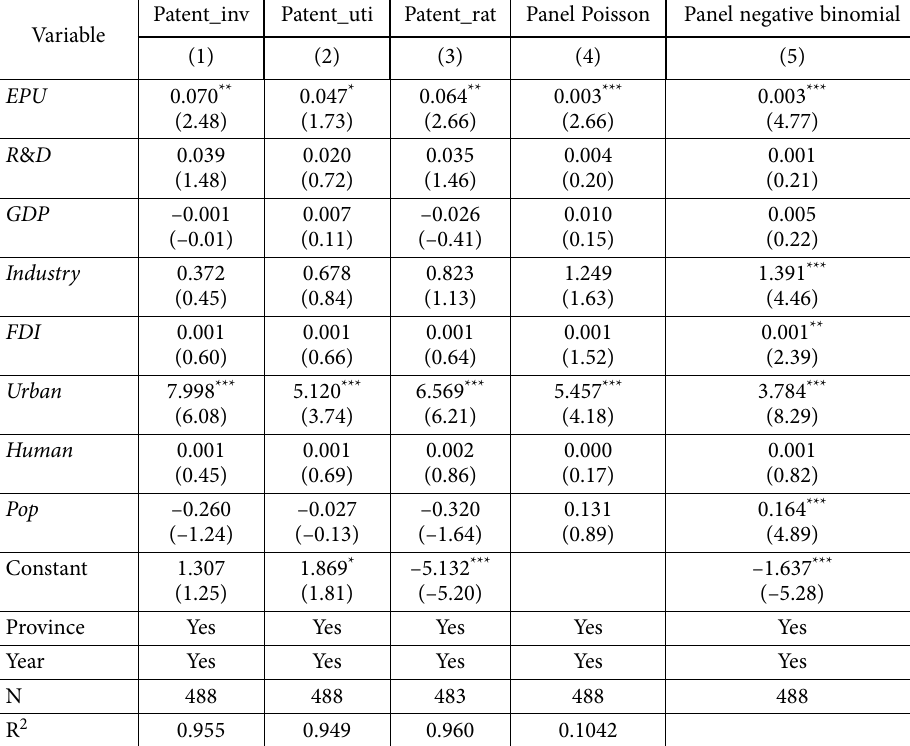
Table 6. Robustness tests: alternative dependent variables and regression